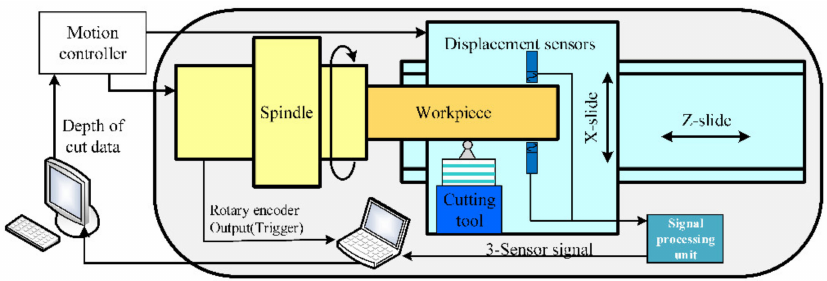
Figure 2. Schematic representation of the measurement and compensation system.